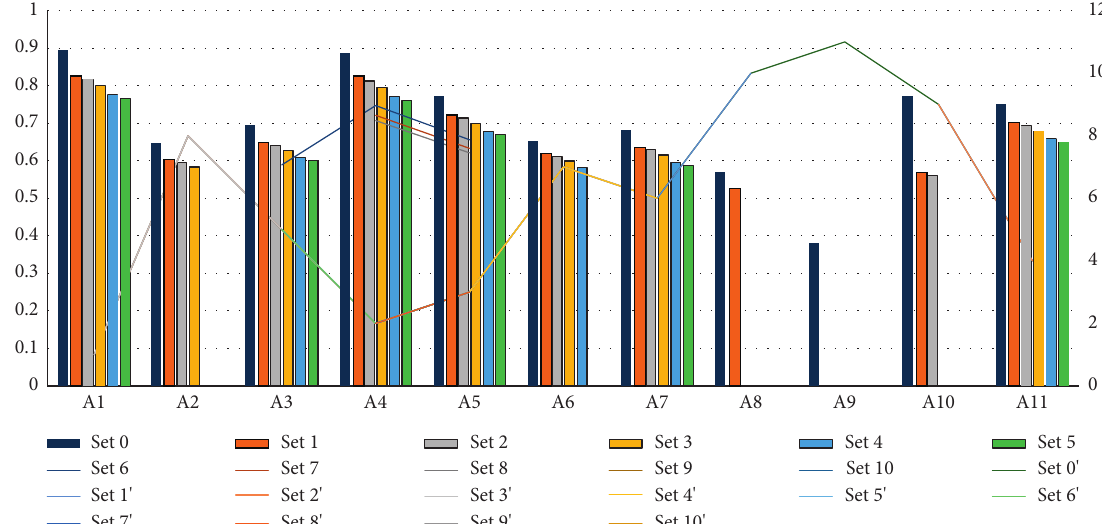
Figure 6: Results after resizing the Rough MARCOS initial